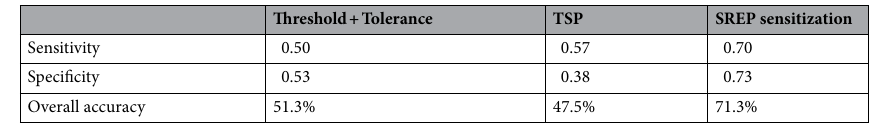
Table 2. Sensitivity and specificity values and overall accuracy for the discrimination between EM and healthy individuals using pain threshold + tolerance (combined), Temporal Summation of Pain (TSP), and Slowly Repeated Evoked Pain (SREP)